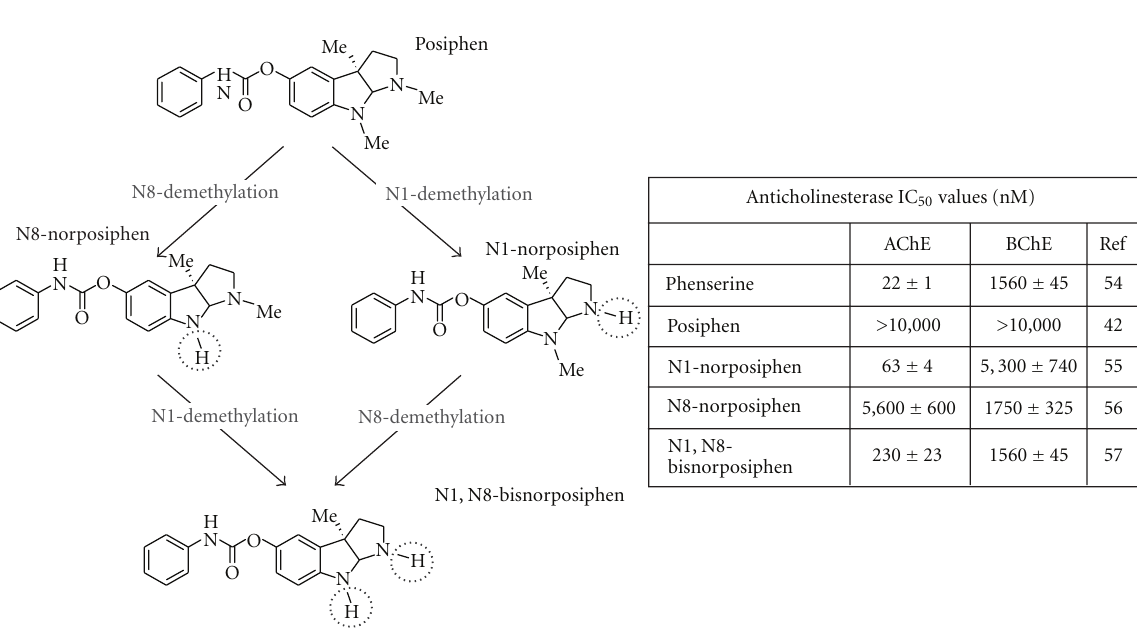
Figure 5: Metabolic analogs of posiphen and their respective anticholinesterase activities [60]. Posiphen is devoid of anticholinesterase activity. However, its phase 1 metabolites, N8 demethylated, N1 demethylated, and di-demethylated N1, N8-bisnorposiphen showed ex vivo AChE and BChE inhibitory activity of clinical relevance [61, 62]. The compound N8-bisnorposiphen demonstrated no AChE activity. This activity has proven to be dose limiting in human safety